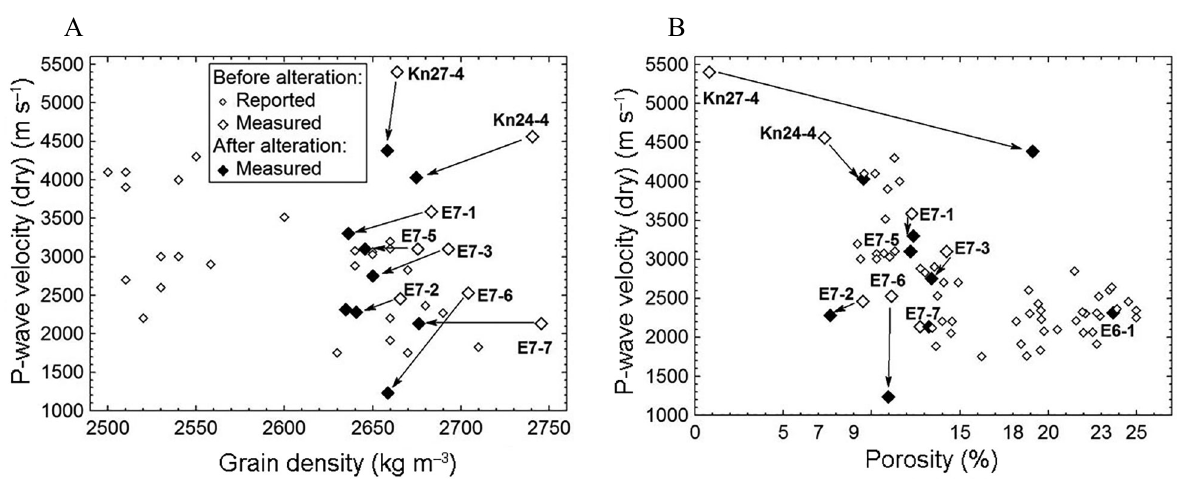
Fig. 5. ( A ) P-wave velocity versus grain density in dry sandstones of the Deimena Formation, reported (27 samples), and measured before (8 samples) and after (9 samples) the alteration experiment; ( B ) P-wave velocity versus porosity in dry sandstones, reported (52 samples), and measured before (8 samples) and after (9 samples) the alteration experiment (for legend see Fig. 5A). A decrease in the grain density in all samples and a decrease in the velocity in most of the samples were determined after the